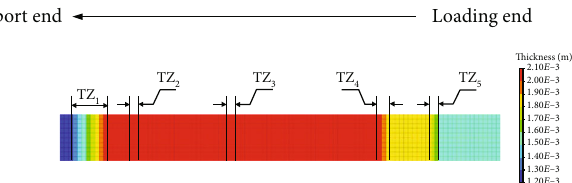
Figure 16: Thickness distribution of the TRB tube.